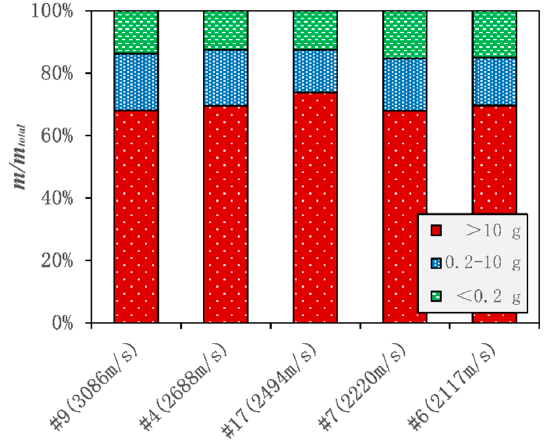
Figure 10. Mass distribution of the concrete fragments.